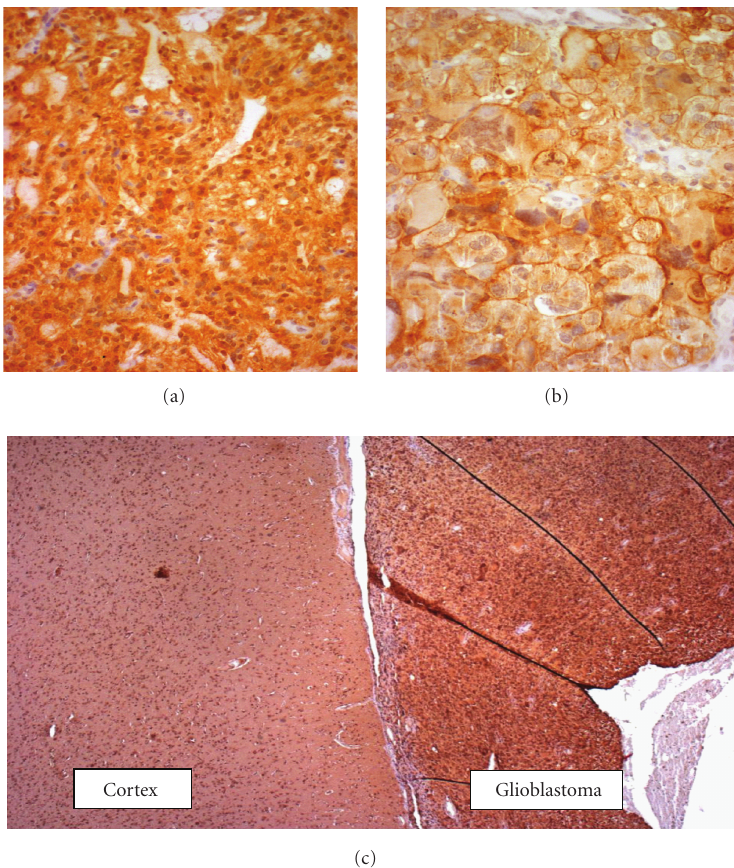
Figure 2: Dpl immunohistochemistry localization in glioblastoma and peritumoral cortex sections. Dpl was detected using Dpl-Val antibody. Panels (a) and (b) represent sections of two di ff erent glioblastomas, one of which showing a marked Dpl immunoreactivity in the cytoplasm (Panel (a)), and the other at the plasma membrane (Panel (b)) (original magnification 200x). A low Dpl immunoreactivity is exhibited by the peritumoral cortex (Panel (c), left), compared to the glioblastoma area (Panel (c), right) (original magnification 25x).